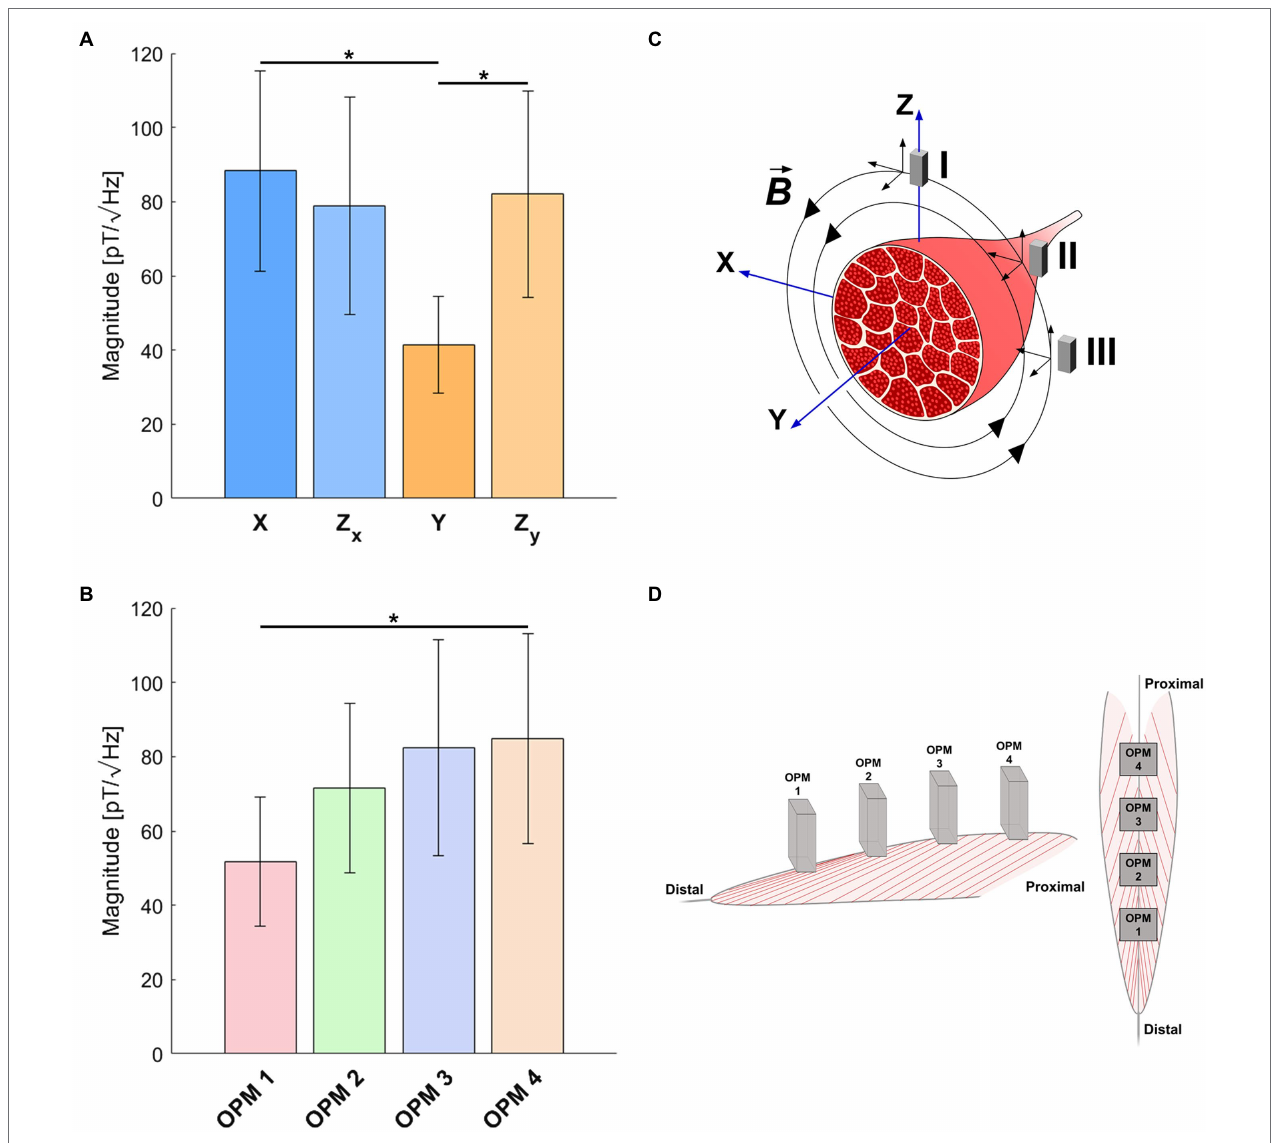
FIGURE 5 | Comparison of the average signal strength at different OPM sensors position and for different vector components. (A) Averaged signal strength across the 4 OPM sensors is compared between vector components. (B) Averaged signal strength across the 4 vector components (Z X and Z Y separately considered) is compared between the 4 OPMs. Error bars indicate SEM across participants ( * p <0.05 ). (C) Model of the magnetic field generated by the electric activity of the muscle. Signal strengths of the recorded spatial components of the magnetic fields are a function of the propagation direction of the motor action potential along the muscle fibers and the sensor positions and orientations. For a detailed explanation of the model and the speculations that can be drawn from the strength of the magnetic field components for the propagation direction of muscular electrical activity, refer to the discussion. (D) Graphic representation of the OPMs distribution over the